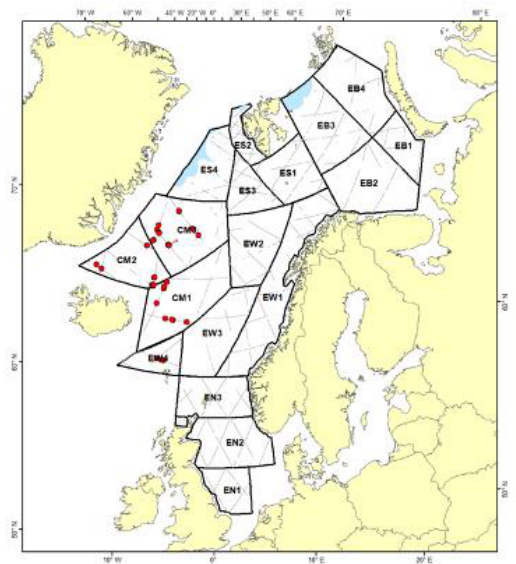
Figure 11. Distribution of sightings recorded as harbour porpoises during the 2014 – 2018 sighting surveys. The blue areas represent ice coverage.